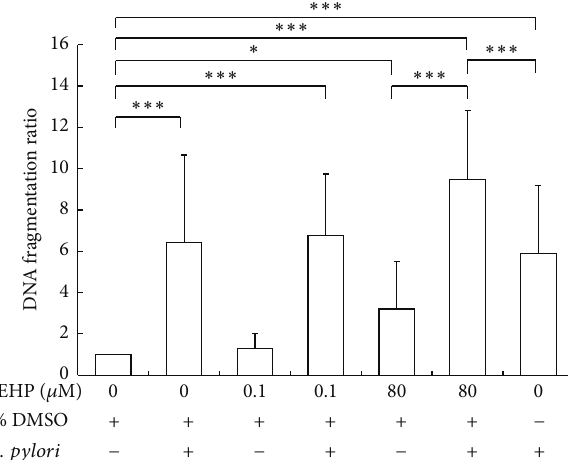
Figure 2: DEHP and H. pylori (MOI = 100:1) exposure induced DNA fragmentation of AGS cells. The level of apoptosis occurring with each treatment was determined by cell death ELISA Plus